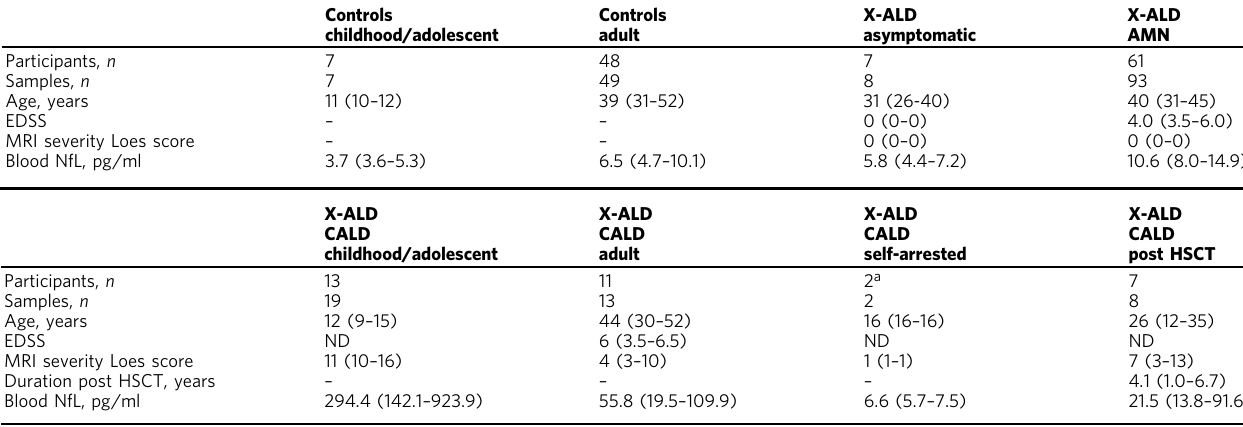
Table 1 Baseline group characteristics of X-ALD variants and healthy